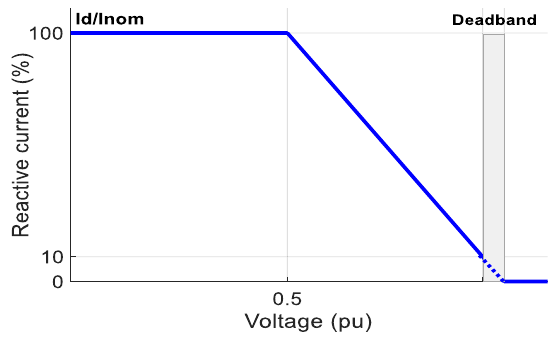
Fig. 2 Reactive current requirements for the